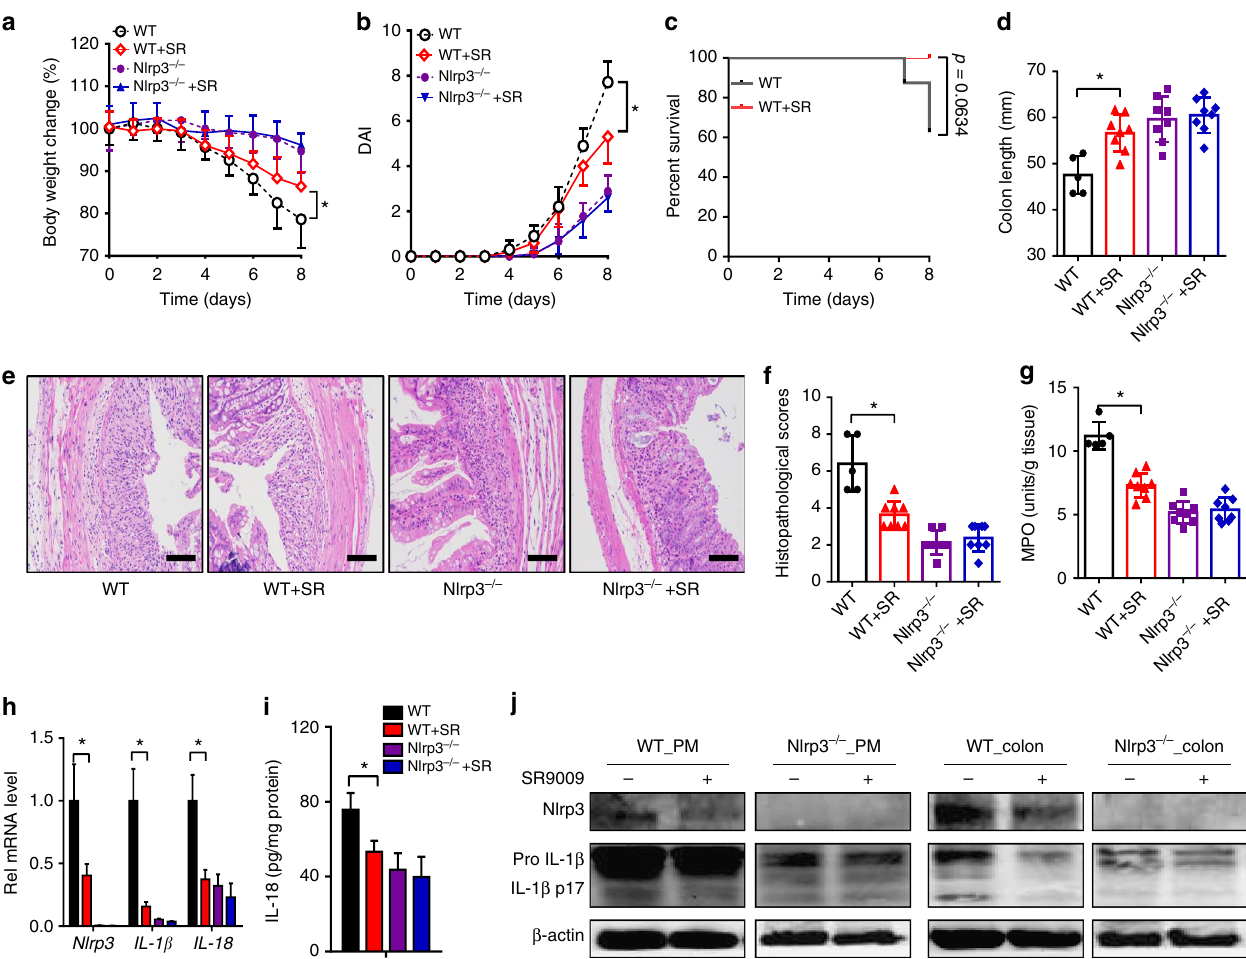
Fig. 7 Rev-erb α activation alleviated experimental colitis in mice. a Weight loss measurements of four groups of mice with DSS feeding. b DAI scores of four groups of mice with DSS feeding. In panels a and b , data are mean ± SD ( n = 8). * P < 0.05 ( t test). c Survival rates of SR9009-treated and control mice (log-rank test). d Colon lengths of four groups of mice treated with DSS. Colon length was assessed at the time of necropsy. e Representative micrographs of colon H&E staining. Scale bar = 100 µ m. f Histopathological scores of four groups of mice treated with DSS. g MPO activities of mice colons on day 8. h qPCR analyses of Nlrp3 , IL-1 β , and IL-18 expressions in whole colon tissues of mice with colitis on day 8. i ELISA measurements of colonic IL-18 protein on day 8 after DSS feeding. j Western blotting of Nlrp3, IL-1 β , and β -actin in PMs or colons from mice with colitis on day 8. Each western blot is representative of three independent experiments (statistical differences between blot density levels were analyzed by Mann – Whitney U test, Supplementary Figure